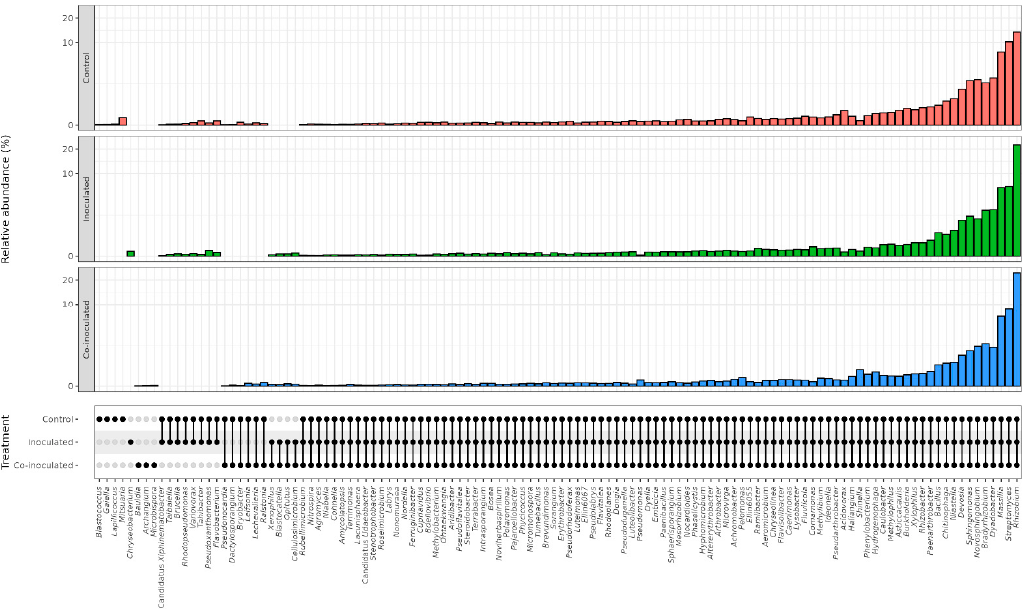
Figure 6. Genera of bacteria in the microbiomes of common bean roots in the treatments (i) non-inoculated (control); (ii) inoculated with Rhizobium tropici ; and (iii) co-inoculated with R. tropici and Azospirillum brasilense .